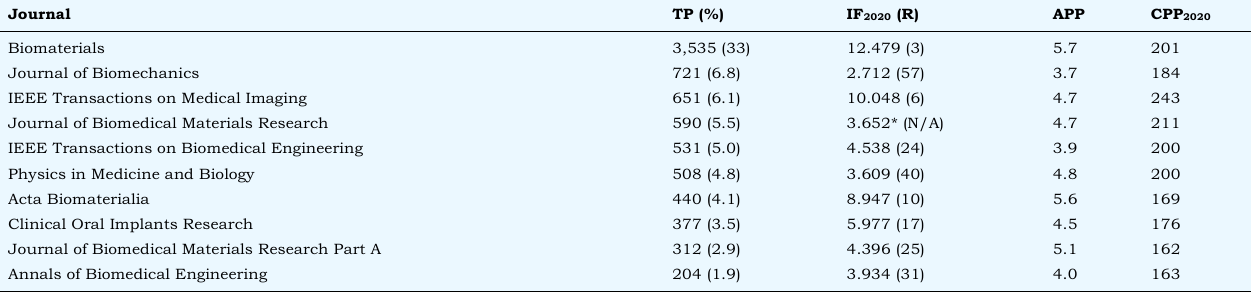
Table 2 Top 10 productive journals with highly cited articles in the Web of Science category of biomedical engineering.